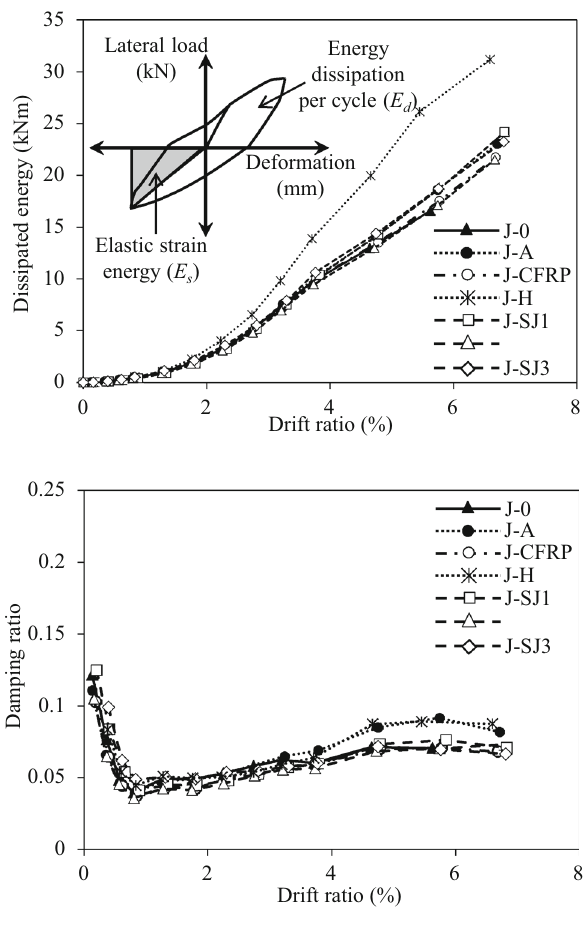
Fig. 20 Effects of various retrofit applications on dissipated energy and damping